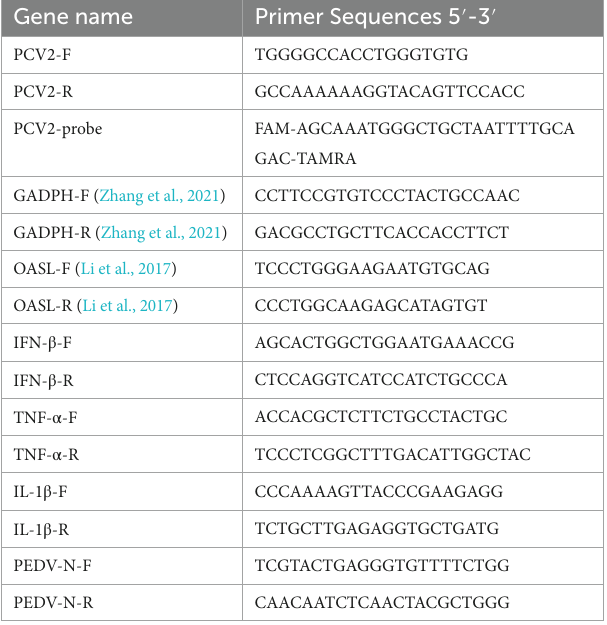
TABLE 1 Specific primers and probe for